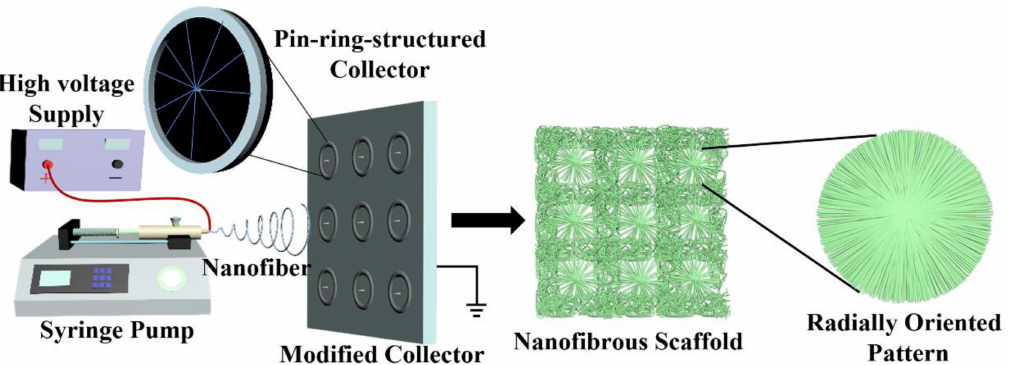
Figure 1. Schematic of our innovative electrospinning device that employs a series of pin-ring- structured collectors as an electrospun nanofiber-collecting device to generate a radially oriented nanofiber